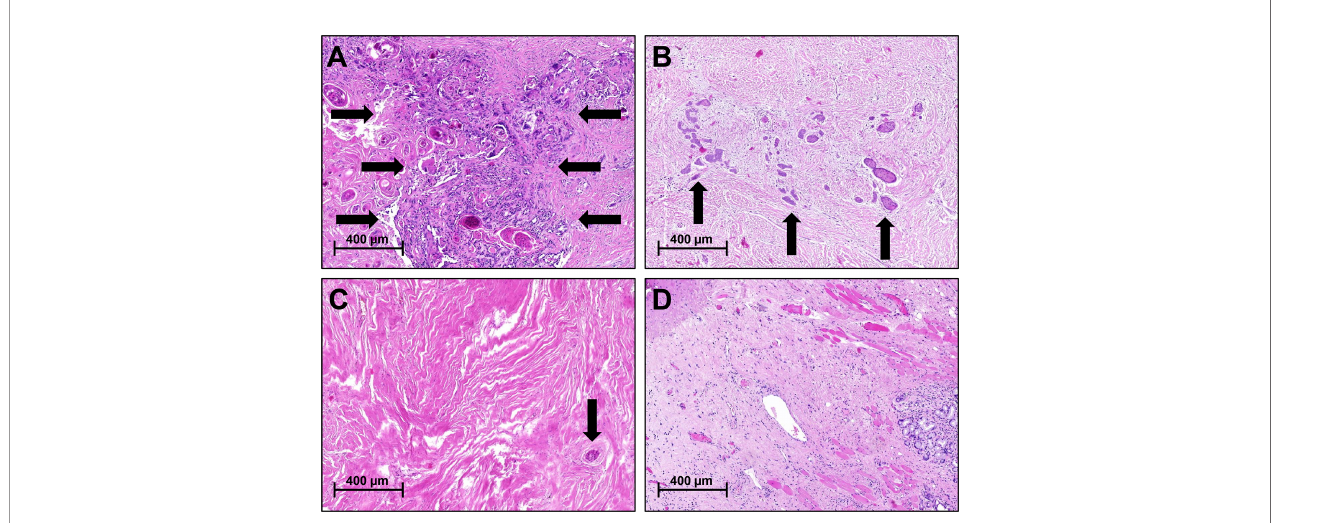
FIGURE 1 | Pathological Response Patterns Following Neoadjuvant Chemoradiotherapy. (A) No/minimal tumor regression, vital tumor cells, and prominent keratin pearls; (B) Tumor fragmentation with increased amount of fi brous connective tissue with scattered groups of vital tumor cells; (C) Tumor shrinkage with a solitary group of vital tumor cells embedded in fi brous connective tissue; (D) Complete response with no vital tumor cells within fi brous connective tissue; salivary glands, and skeletal muscles located on the